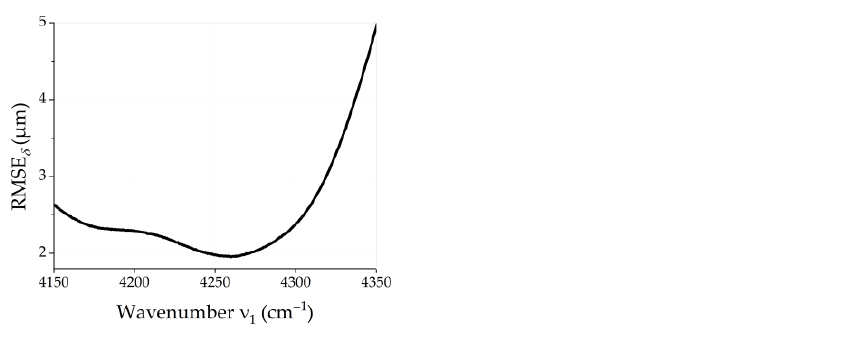
Figure 4. RMSE 𝛿 of the difference between the known 𝛿 and the calculated film thicknesses 𝛿 𝑐𝑎𝑙𝑐 (calculated from the calibration set) over wavenumber 𝜈 1 .